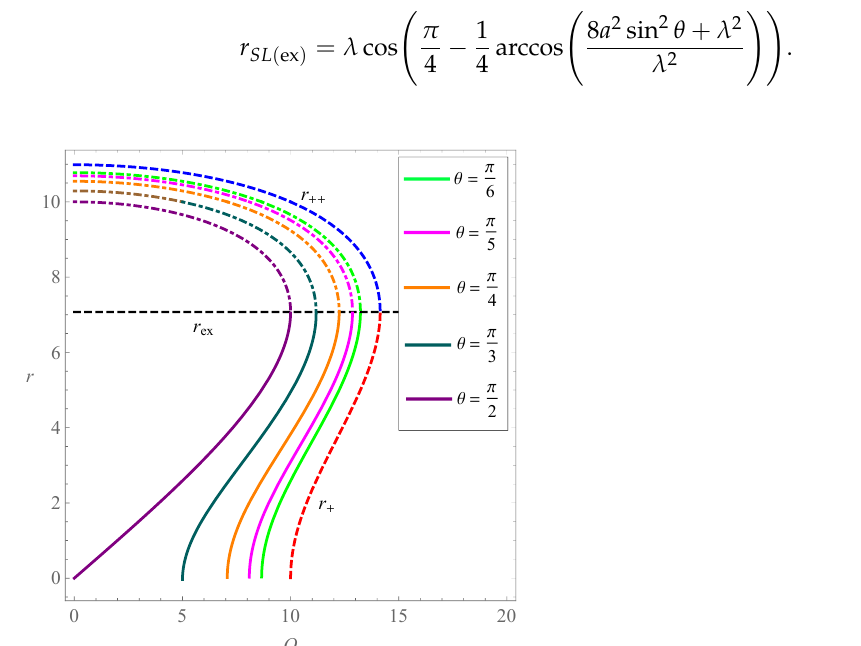
Figure 3. The behavior of r SL , with respect to changes in Q . The plots were made for λ = 10 and a = 5 and five different values of θ . The solid and dot-dashed curves correspond, respectively, to r SL 1 and r SL 2 , and the black hole horizons are shown with dashed